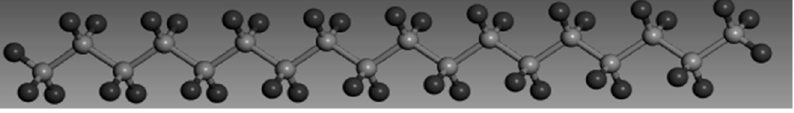
Figure 1. Molecular structure of n -octadecane. (Grey spheres: Carbon atoms, black spheres: Hydrogen atoms.)